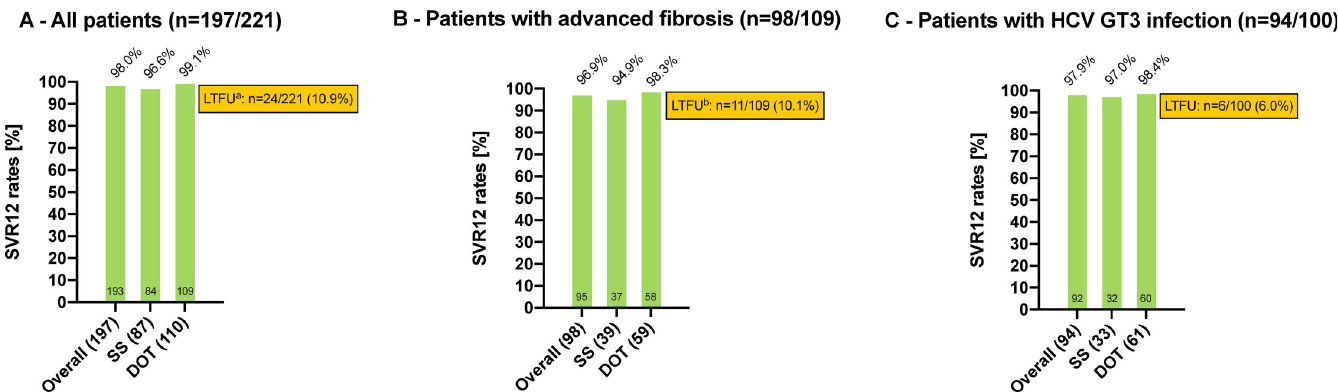
Fig 3. SVR12 rates after treatment with SOF/VEL after LTFU exclusion. Abbreviations: SVR, sustained virologic response; SOF/VEL, sofosbuvir/velpatasvir; LTFU, lost to follow-up; SS, standard setting; DOT, directly observed therapy; HCV, hepatitis C virus; GT, genotype. A—All patients (n = 197/221) . a including n = 2 patients who died for reasons not related to treatment after showing a negative HCV-RNA PCR result at week 2 of therapy and at the end of treatment, respectively. B—Patients with advanced fibrosis (n = 98/109) . Advanced fibrosis was defined as F3-F4: � 9.5 kPa according to transient elastography. b including 1 patient who died for reasons not related to treatment after showing a negative HCV-RNA PCR result at week 2 of therapy. C—Patients with HCV GT3 infection (n = 94/100) .